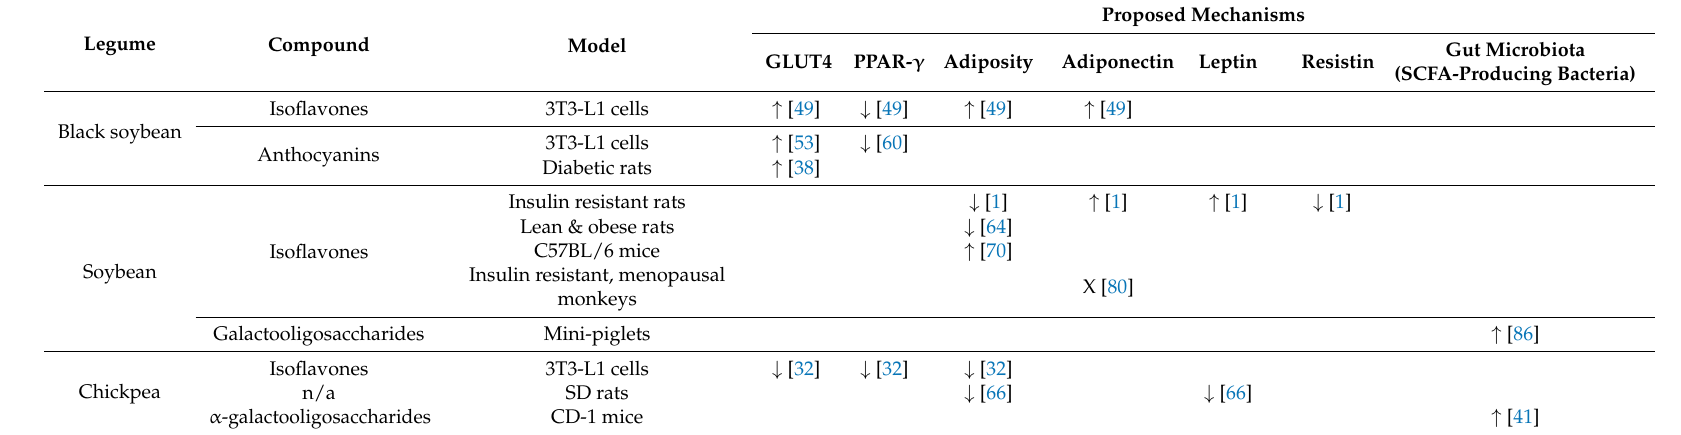
Table 4. Summary of the proposed mechanisms of action of soybeans and chickpeas to improve insulin